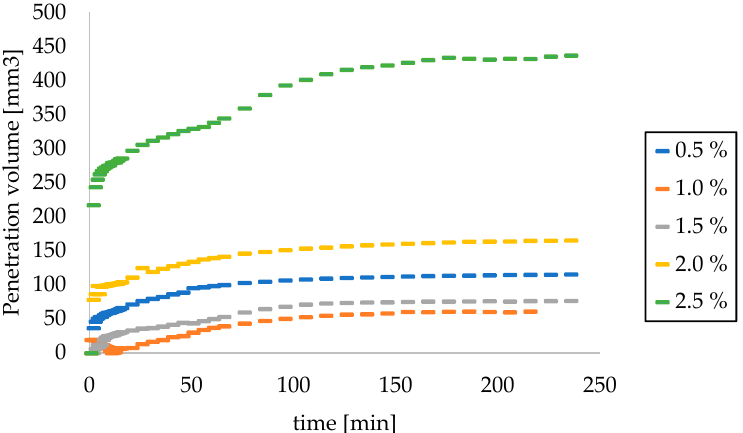
Figure 7. The reacted volume of the model skin sebum was determined based on changes in the pH of AMPD solutions.